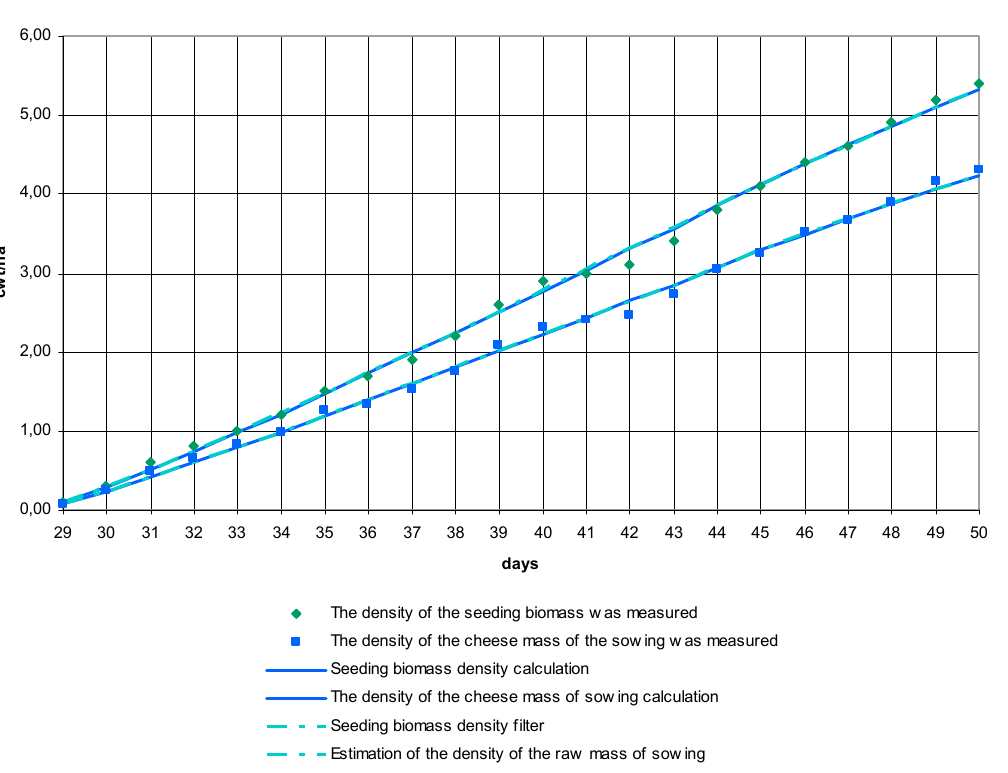
Figure 3. Estimates of the field-averaged parameters of the biomass of spring wheat sowing in the time interval preceding heading.